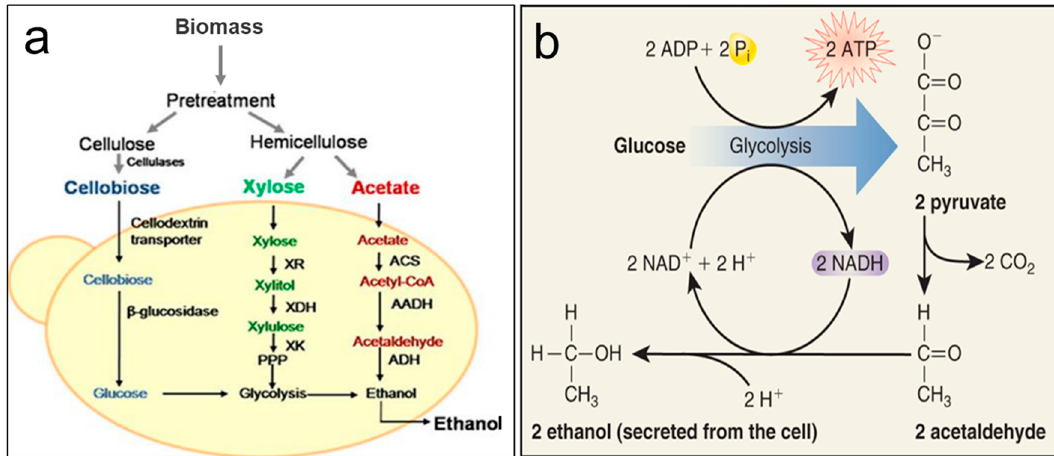
Figure 5. Schematic overview of bioethanol production through utilization of cellobiose, xylose and acetic acid from biomass by yeast ( a ) and the metabolic pathways (glycolysis and fermentation) ( b ), adapted from [70].